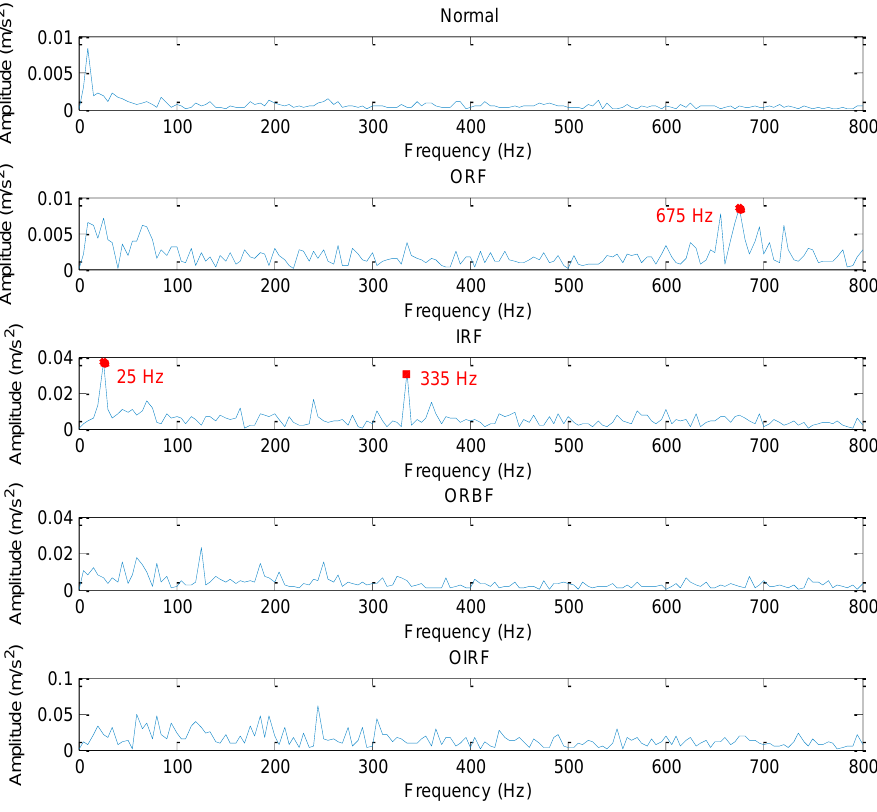
Figure 12. Envelope spectrum of different bearing vibration signals.